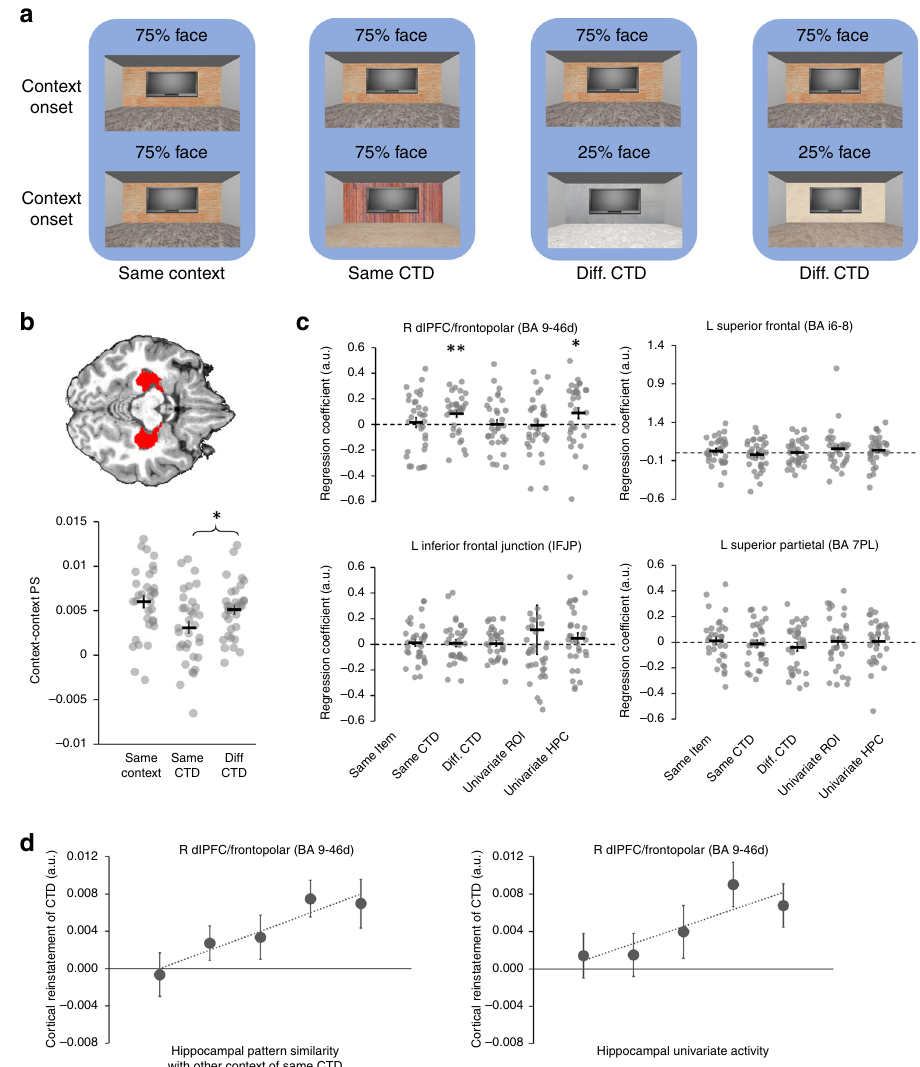
Fig. 5 Hippocampal activity and pattern separation predict cortical reinstatement of CTD. a Four examples (grouped by blue background) of how the CTDs of context A (top row) and context B (bottom row) de fi ne the experimental condition of context – context pattern similarity (text label below the background). b Visualization of the hippocampus ROI (top, in red) and individual data and mean ± SEM of the three conditions of hippocampal context – context pattern similarity (bottom). At the group level, pattern similarity in the Same CTD condition was signi fi cantly lower than the Different CTD condition. c Individual data and mean ± SEM of the regression coef fi cients of each of the four predictors and the ROI univariate activity on the CTD reinstatement in each of the four frontoparietal ROIs. d Quintiles ( x -axis) of group mean of CTD reins tatement in BA 9-46d (±SEM) plotted as a function of hippocampal context – context pattern similarity in the Same CTD condition and hippocampal univariate activity. * p < 0.05; ** p < 0.01. P values are uncorrected and from two-sided one-sample t -tests. The experiment was conducted once ( n = 33 biologically independent samples). Source data are provided as a Source Data fi